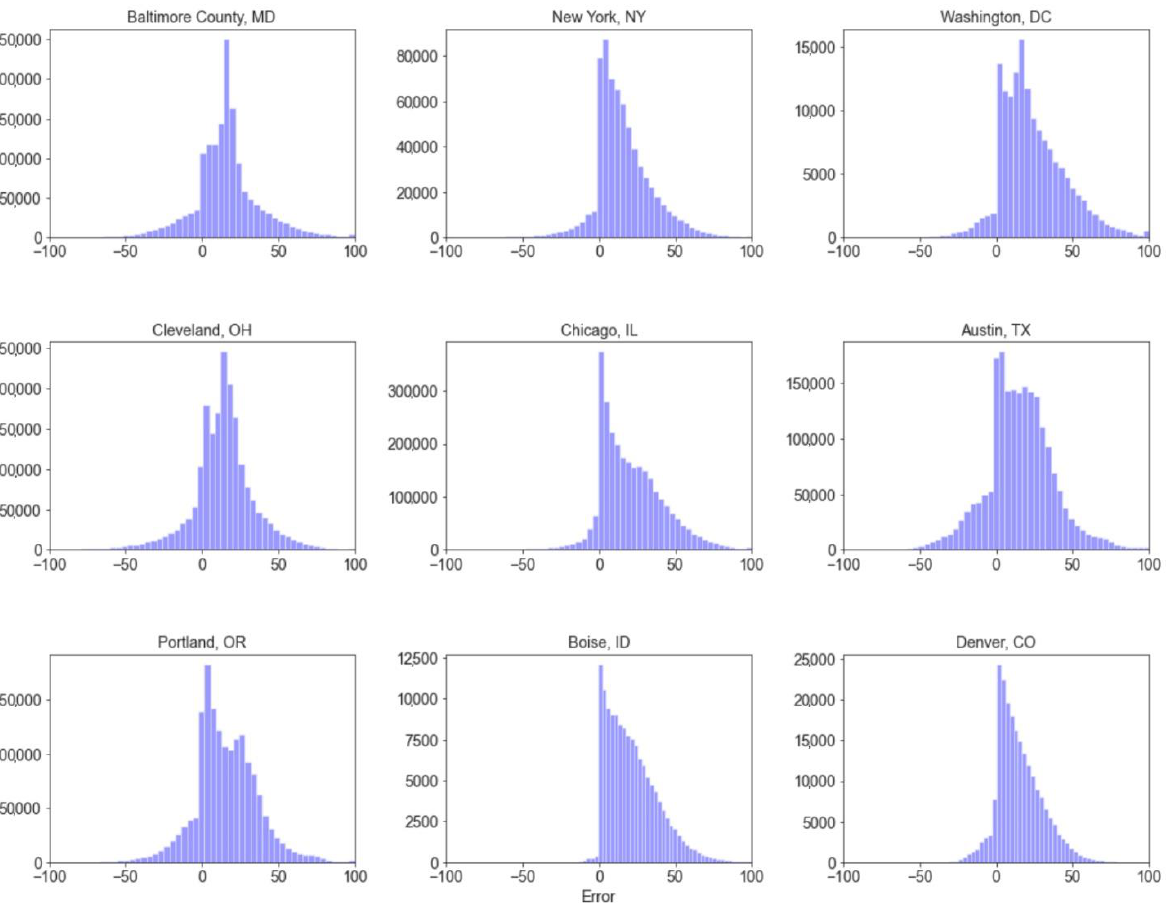
Figure 2. Error (deviation by % when compared to high-resolution derived data) distribution of National Land Cover Database-Tree Canopy 2011 data in all cities.